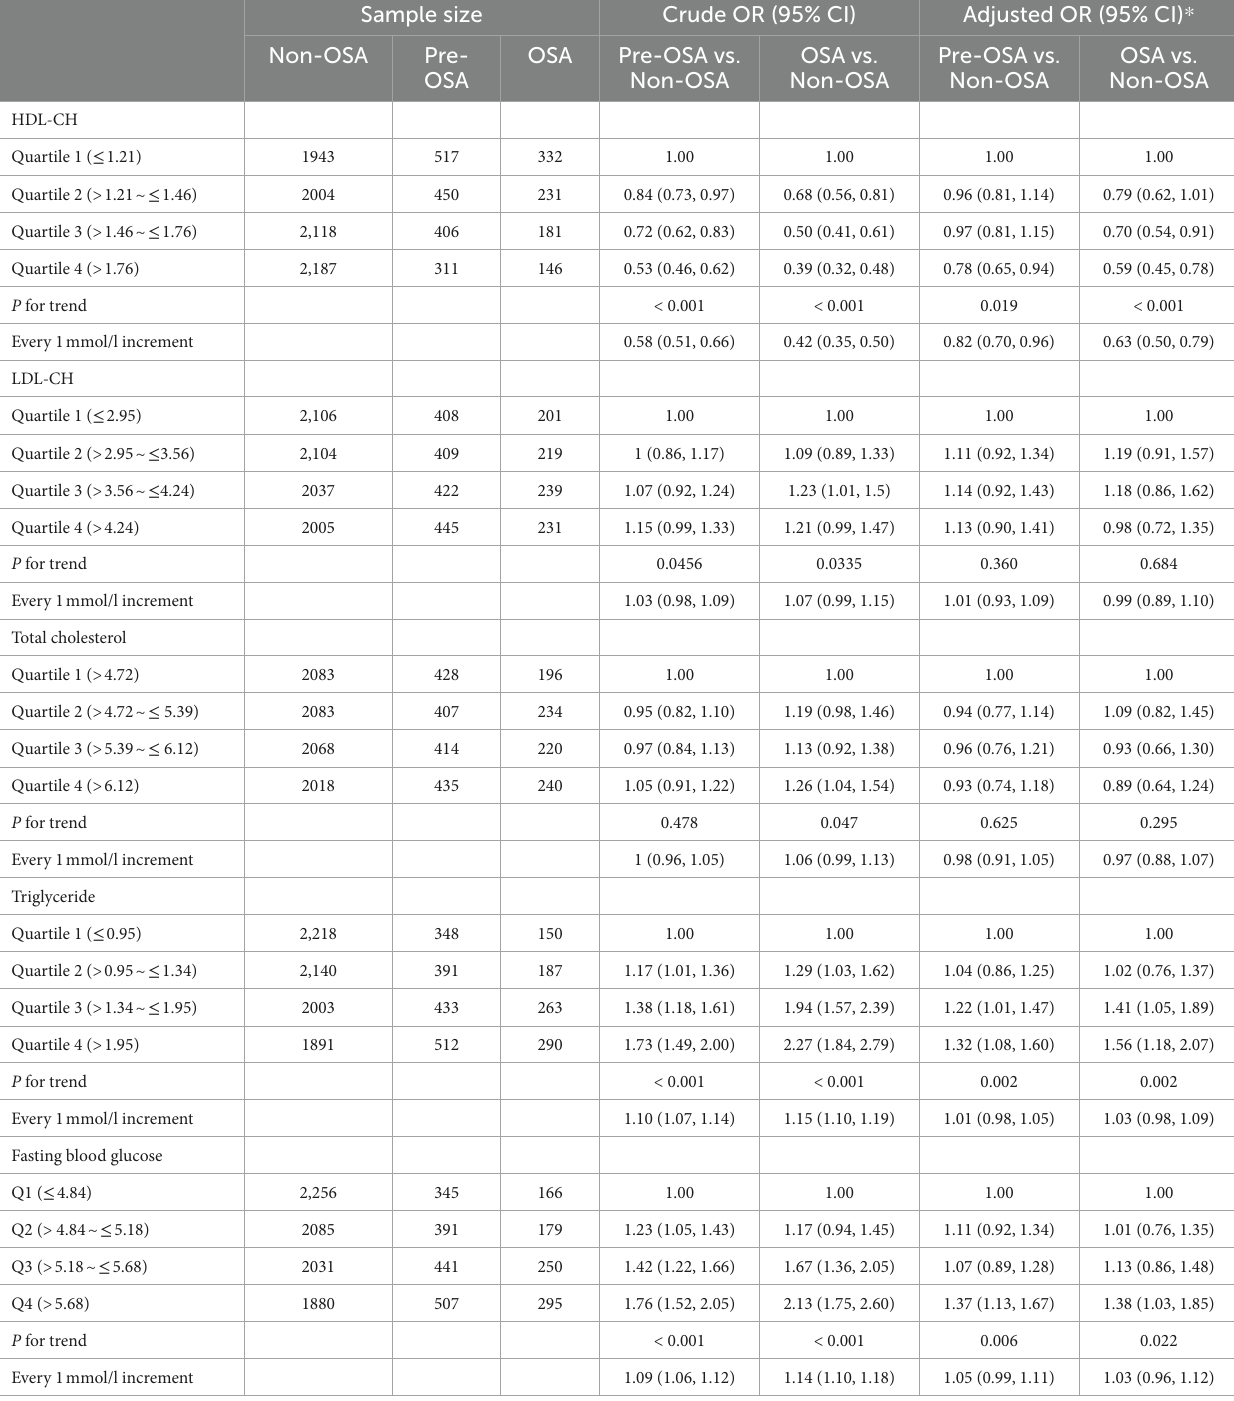
TABLE 2 Association between glycolipid biomarkers and the risk of obstructive sleep apnea. Sample